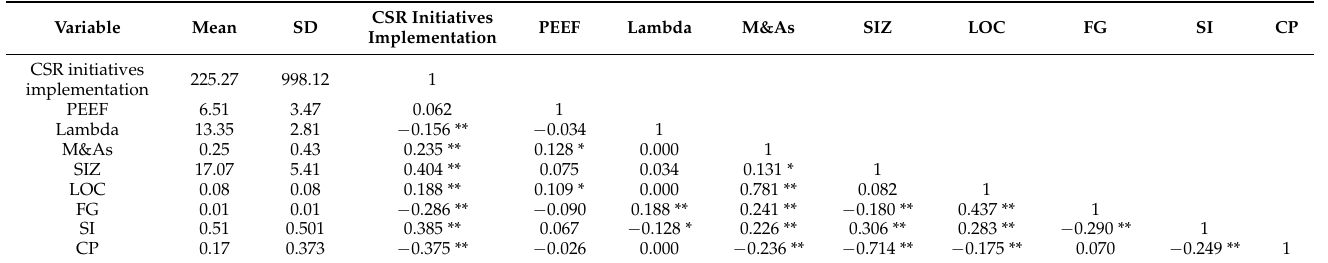
Table 3. Descriptive